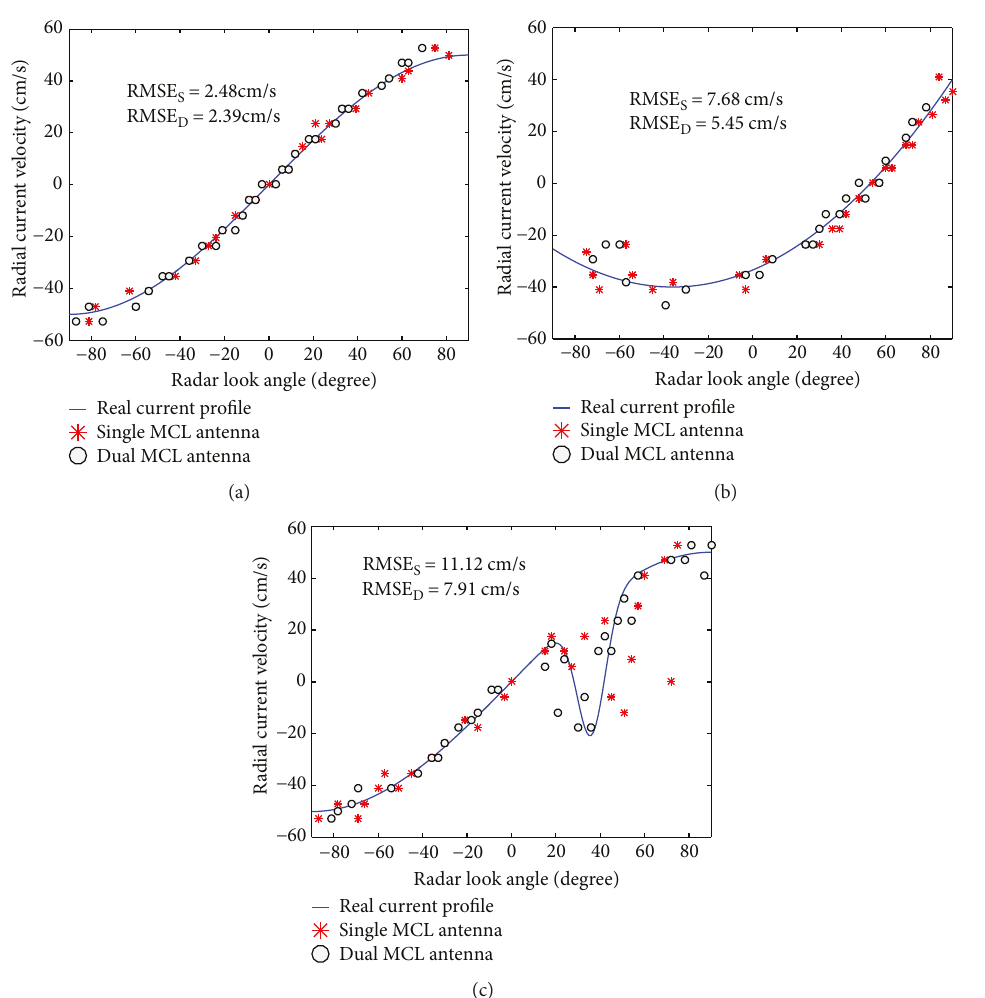
Figure 5: Examples of the radial current pro fi les (solid line) with measurements from conventional single MCL antenna (star) and those from dual MCL antenna array (circle). The RMSE and RMSE are the RMSE values of current comparison results for conventional single MCL S D antenna and the dual MCL antenna array, respectively.